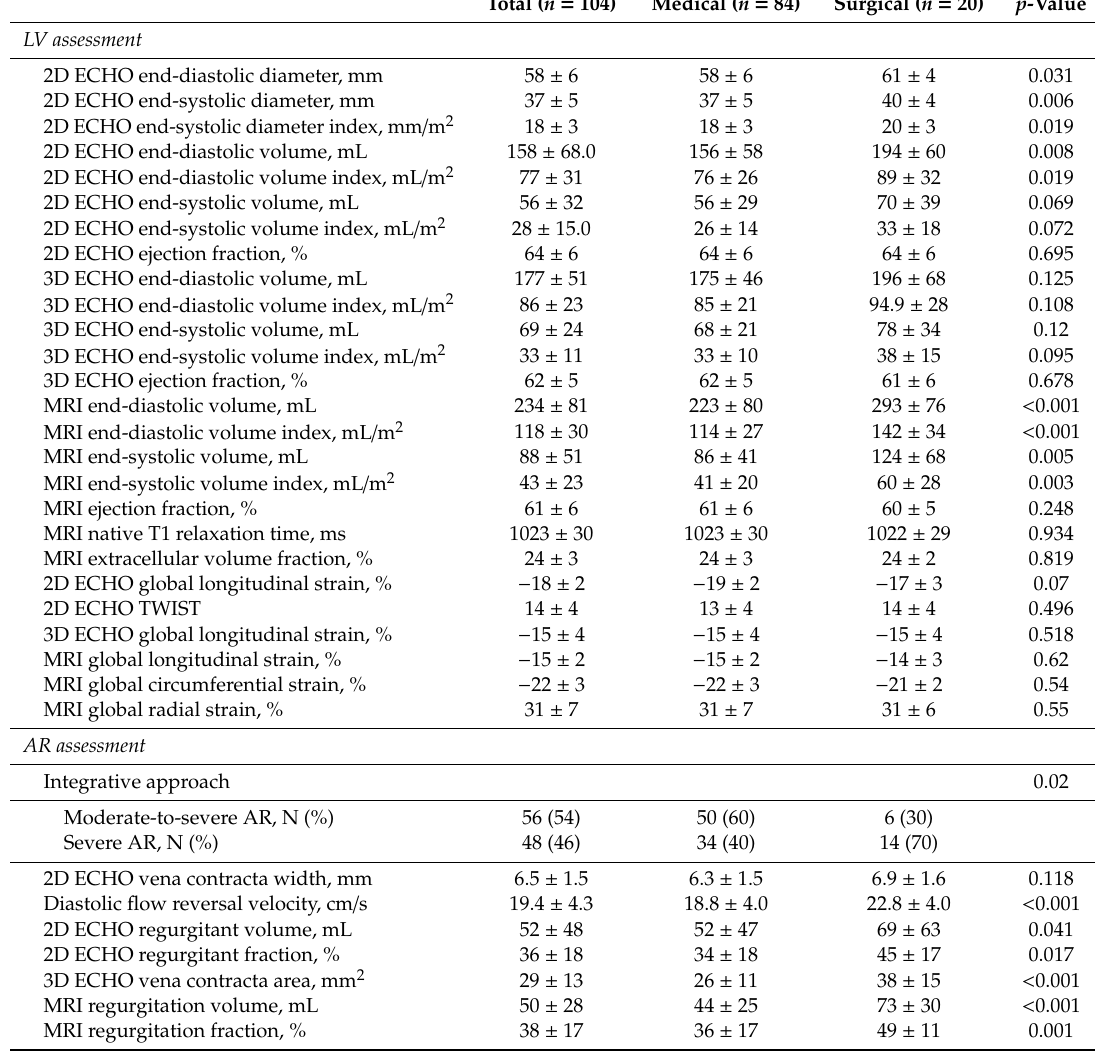
Table 2. Baseline imaging